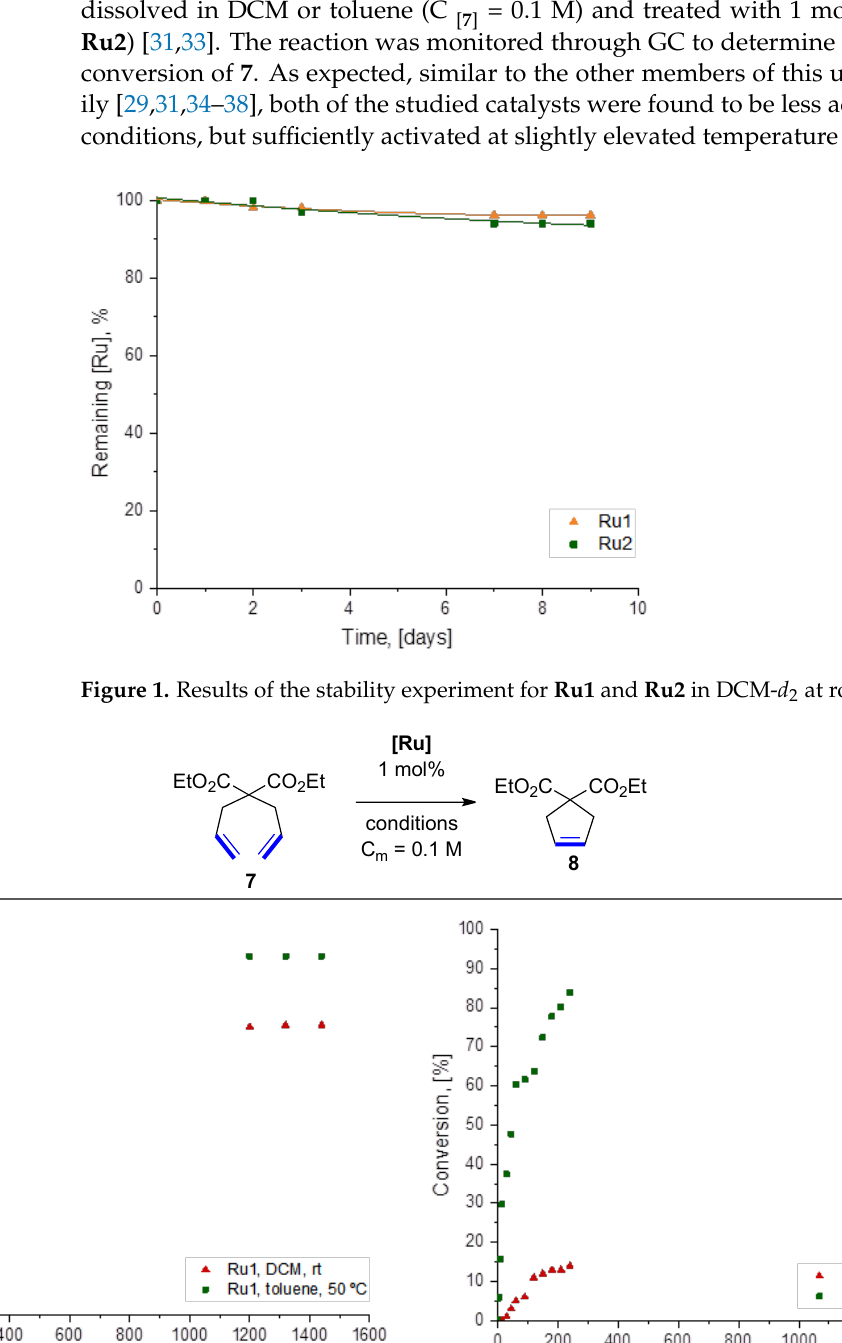
Figure 2. Time/conversion plot for the RCM reaction of 7 (0.1 M) catalysed by Ru1 and Ru2 (1